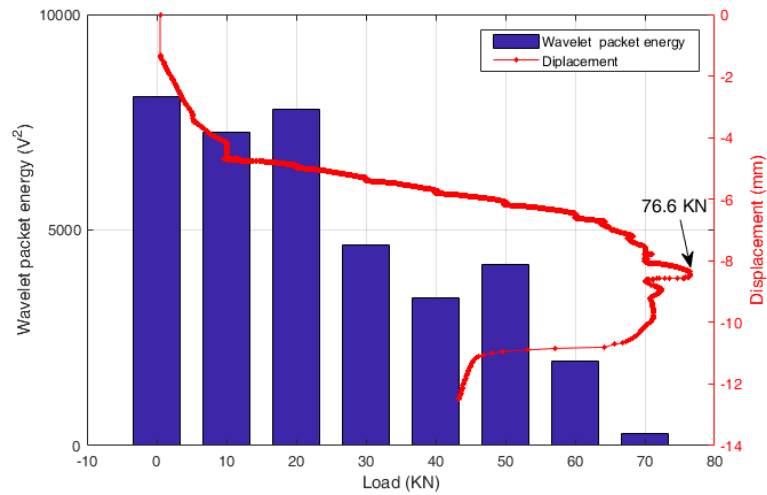
Figure 14. The curves of ( a ) Time vs. load, ( b ) Displacement vs. Load.